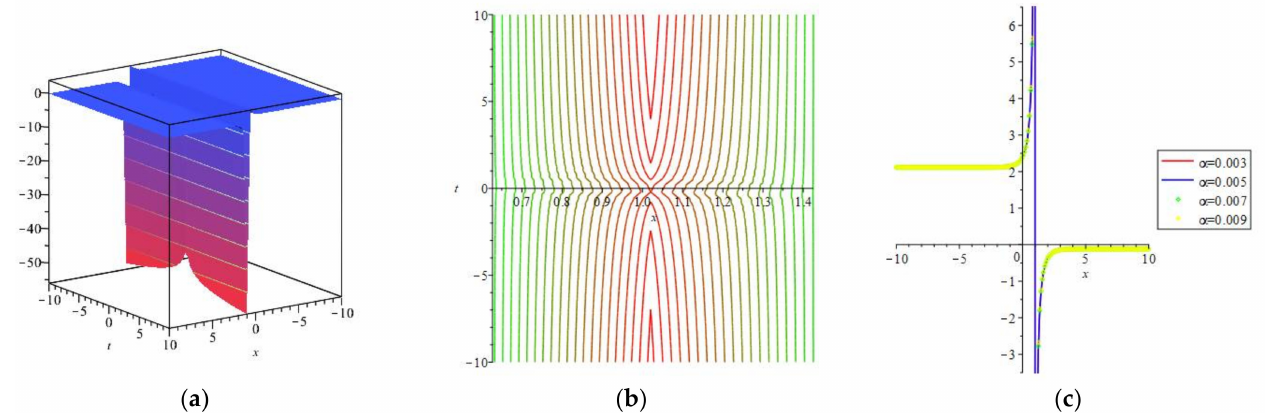
Figure 1. The graphical representation of the solution λ 11 ( χ ) : ( a ) 3D shape, ( b ) contour plot, and ( c ) 2D